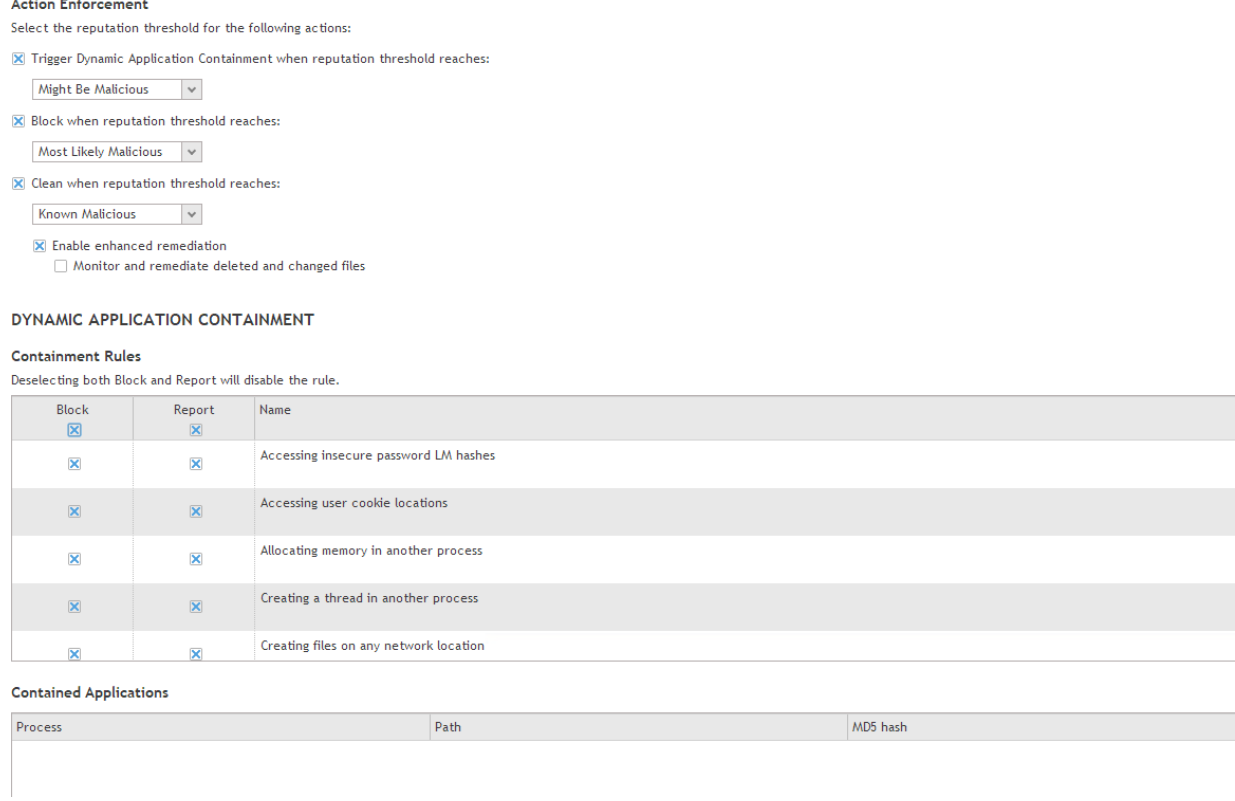
Figure 16. McAfee Endpoint Protection blocking the HTA